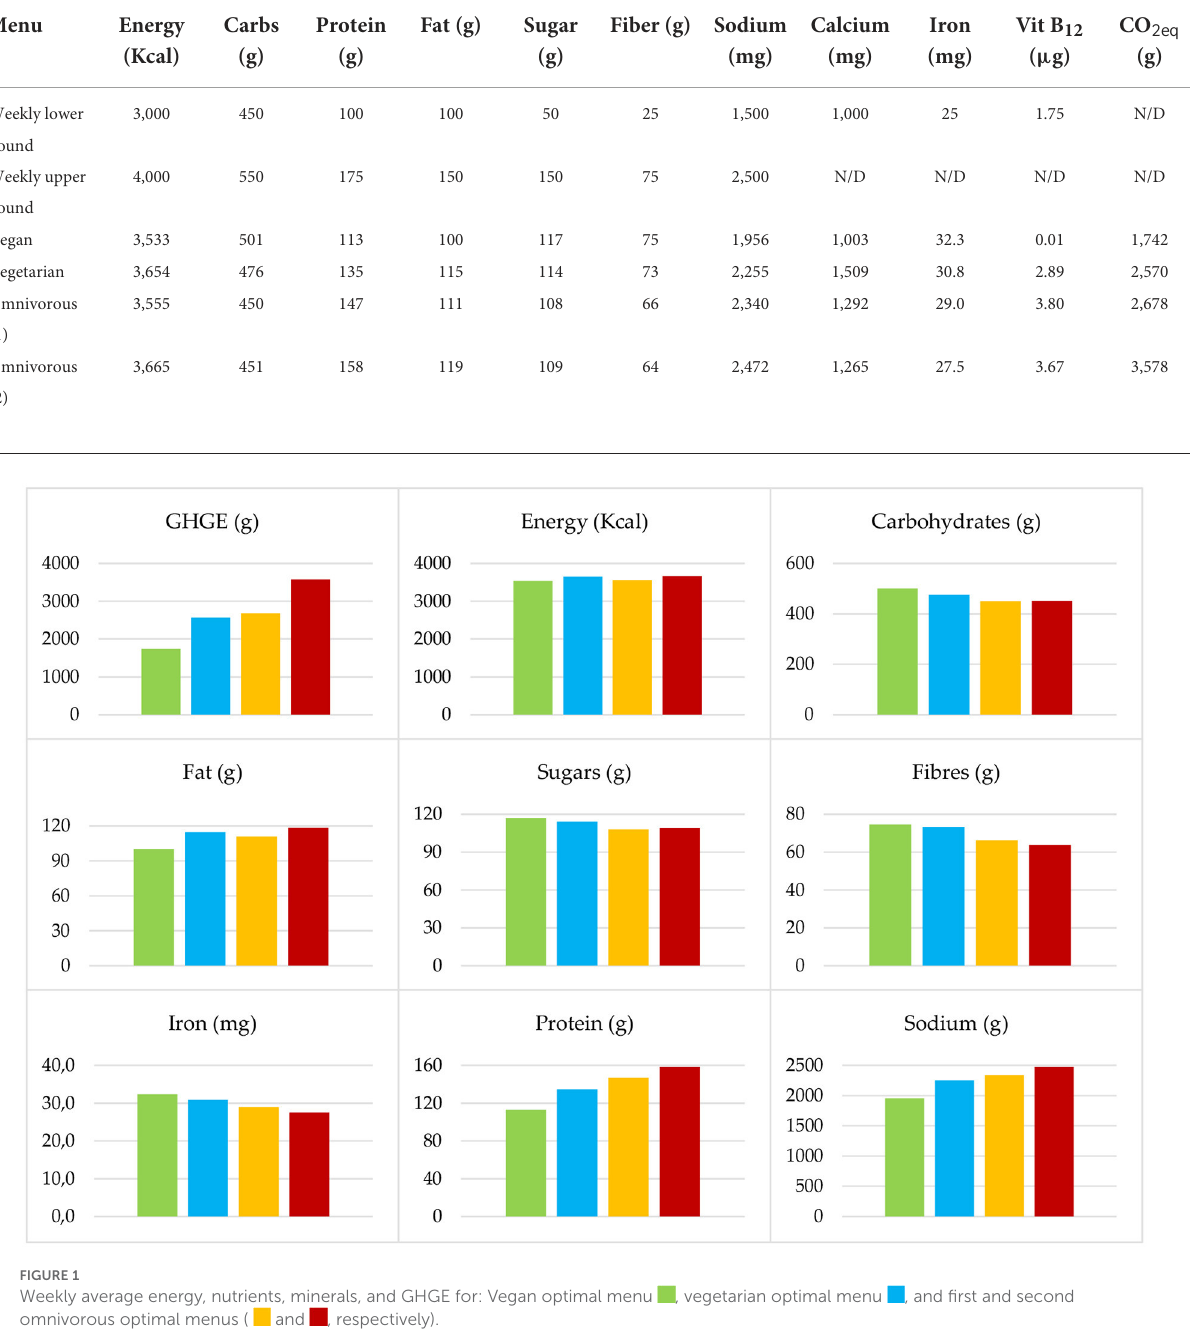
FIGURE1 Weekly average energy, nutrients, minerals, and GHGE for: Vegan optimal menu , vegetarian optimal menu , and first and second omnivorous optimal menus ( and ,